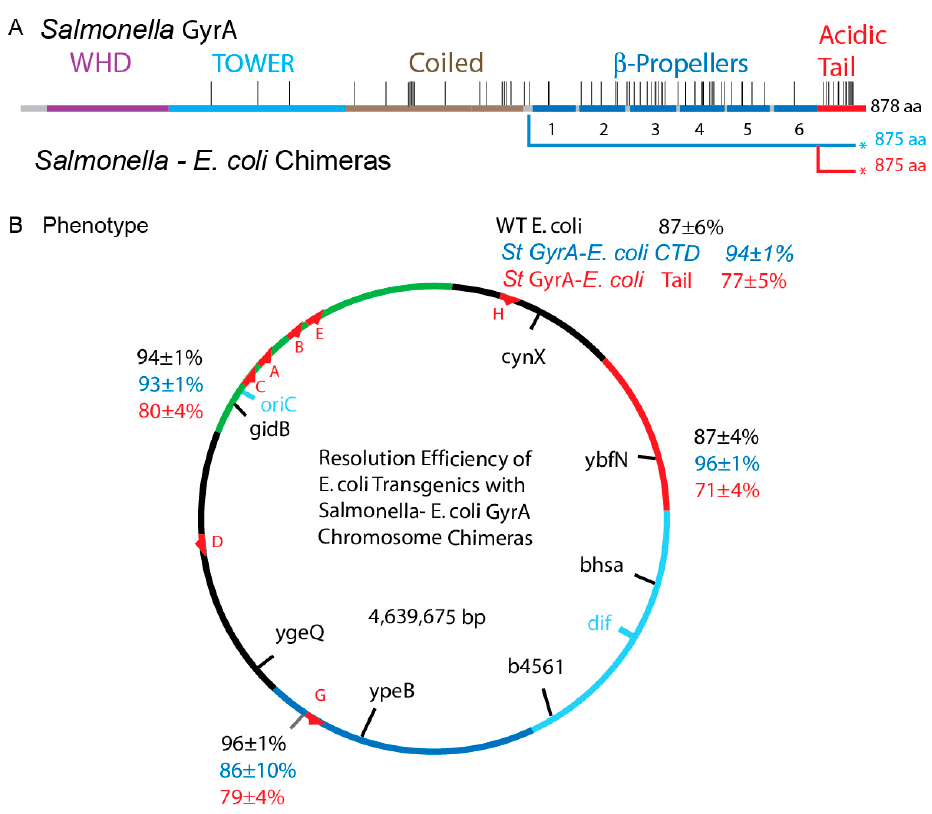
Figure 6. Resolution assays of WT E. coli and E. coli supercoiling with chimeric Salmonella – E. coli GyrA fusions. (A) A map of the genes that were tested. E. coli strains containing a WT GyrA, and two chimeric forms of Salmonella-E. coli GyrA were tested for supercoil-dependent resolution at four sites in the chromosome. (B) Resolvase deletion efficiencies for three gyrA genes are shown at 4 chromosomal locations. Strains with a WT GyrA and a Salmonella GyrA fused to the E. coli CTD at amino acid had very similar efficiencies at all four positions with a mean of 91 ± 5% and 92 ± 3% respectively. Strains carrying the Salmonella chimera fused to only the last 35 amino acids of the E. coli GyrA tail had a mean efficiency of 77 ± 4%, which shows a small (MIF) of 86.